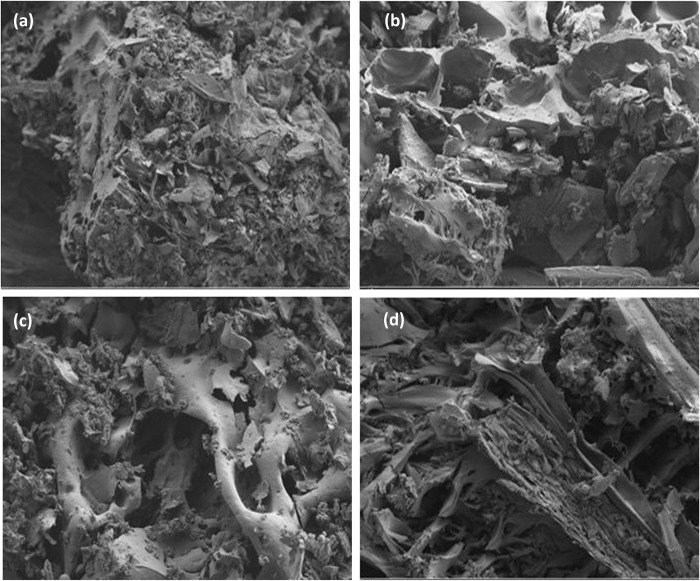
FESEM for adsorbents calcined at temperature 400°C, (a) C400,1, (b) C400,2, (c) C400,3 and (d) C400,4 magnified 1000 times.